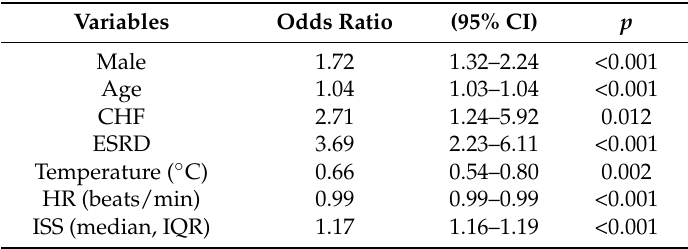
Table 5. Variables related to mortality of the patients in multivariate logistic